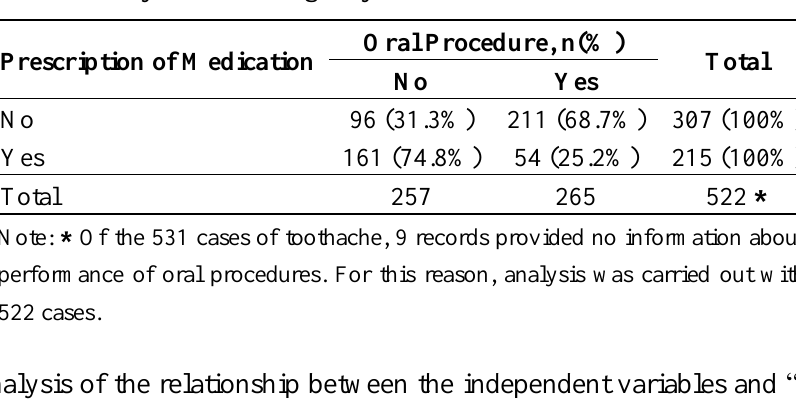
Table 1. Frequency of medication prescription in relation to the performance of oral procedures at community dental emergency services.